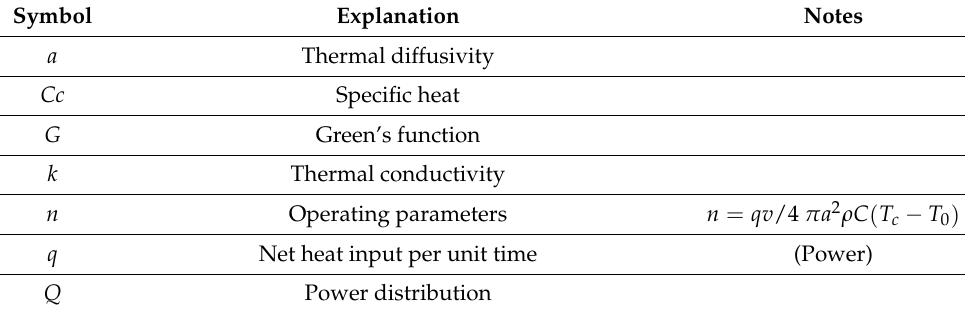
Table A3. List of the parameters and symbols for